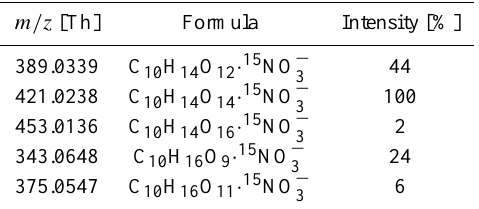
Table 14. Detected and identified dimers observed during ozonoly- sis of